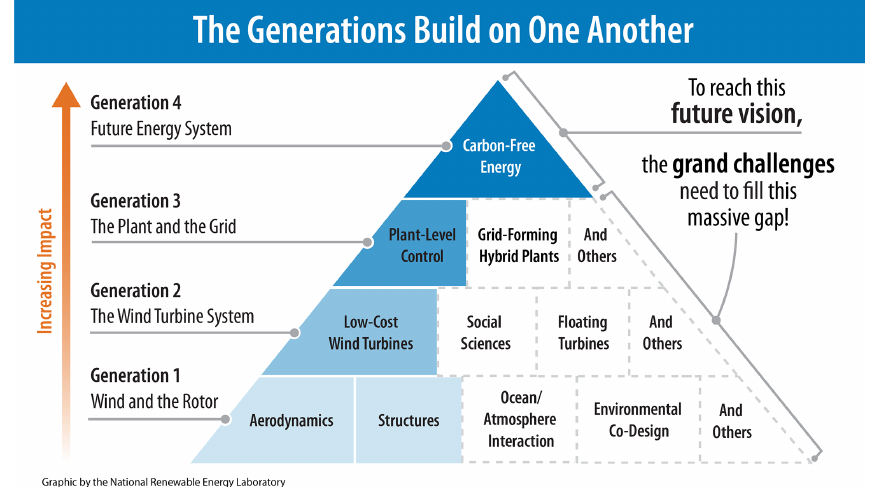
Figure 1. This graphic illustrates the generations of wind energy development. Each generation’s achievements expanded wind energy’s impact (shown in the blue boxes on the left); however, in moving quickly from generation to generation, some underlying science was left unresolved (shown in the white boxes on the right). Generation 1 delivered working energy conversion systems, Generation 2 delivered low-cost and reliable turbines, and Generation 3 is beginning to provide controllable wind plants that support the grid. The aspirational goal of Generation 4 is a carbon-neutral future energy system. Wind can be the foundation for the fourth generation, but not until the gap left behind by the previous generations is addressed. Graphic based on Veers